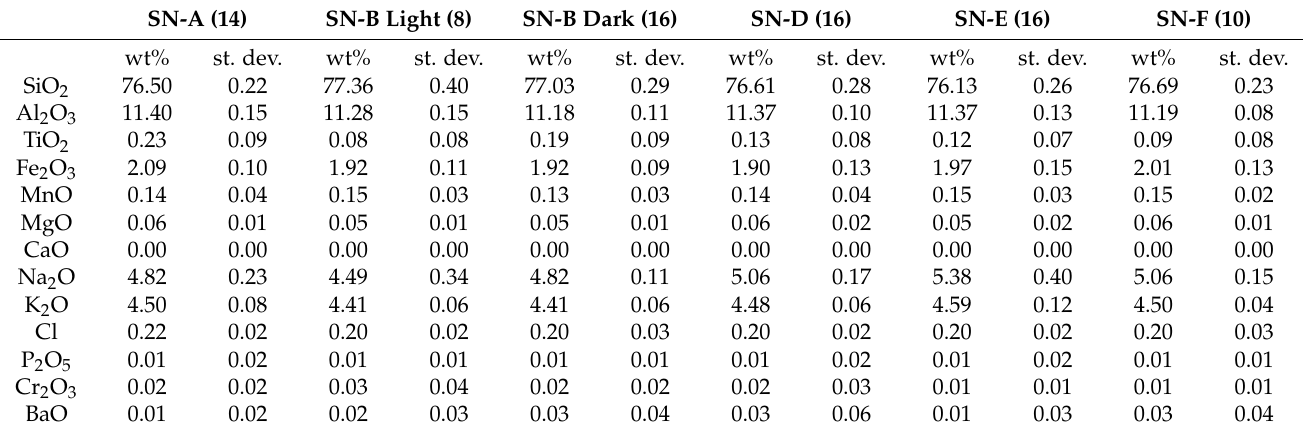
Table 1. Average composition of obsidian glass obtained by